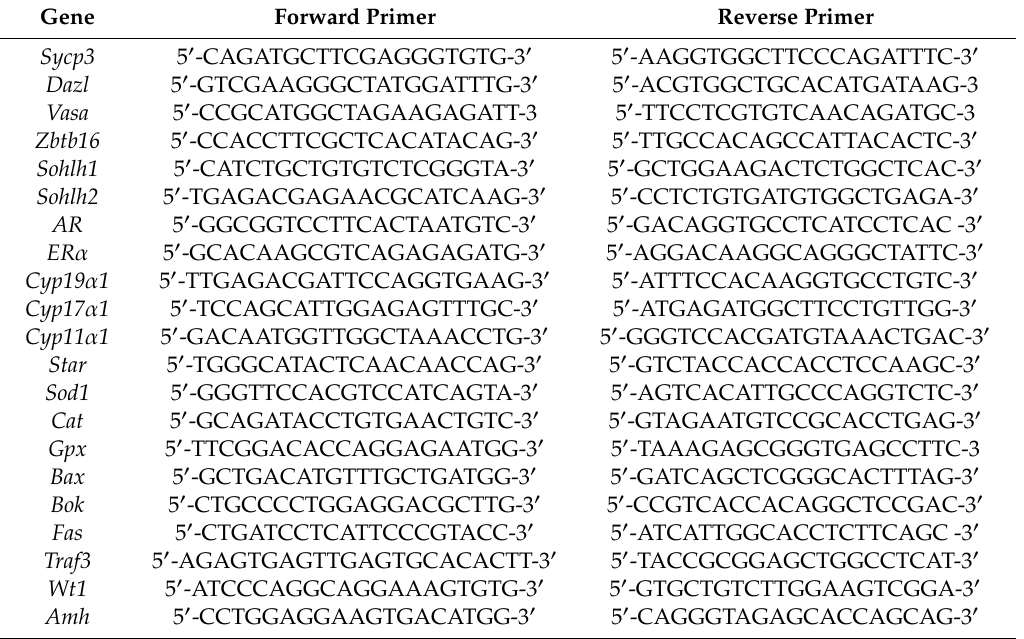
Table 2. Primers used for reverse transcription-polymerase chain reaction using mouse